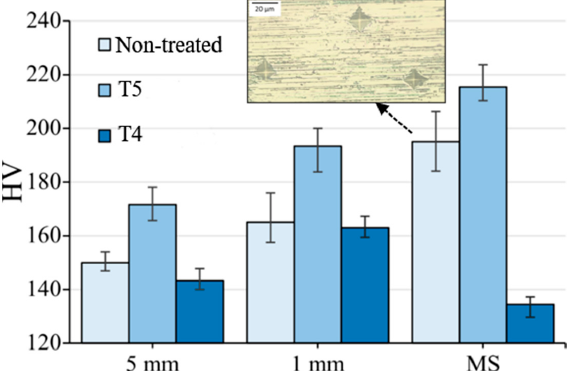
Figure 8. Influence of heat treatment on the hardness of experimental samples of the Al8Zn7Ni3Mg alloy.